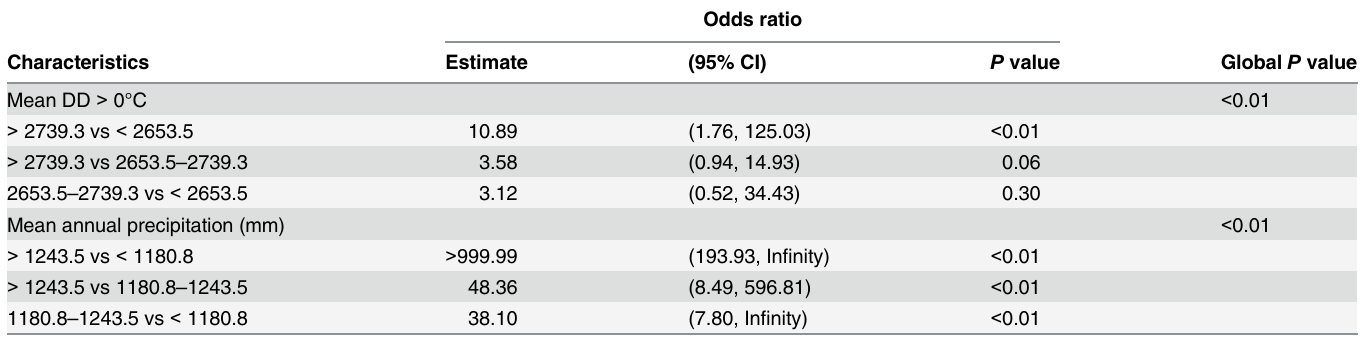
Table 6. Final multivariable exact logistic regression model for predicting whether H . leporispalustris -positive sites were inside or outside the spa- tial